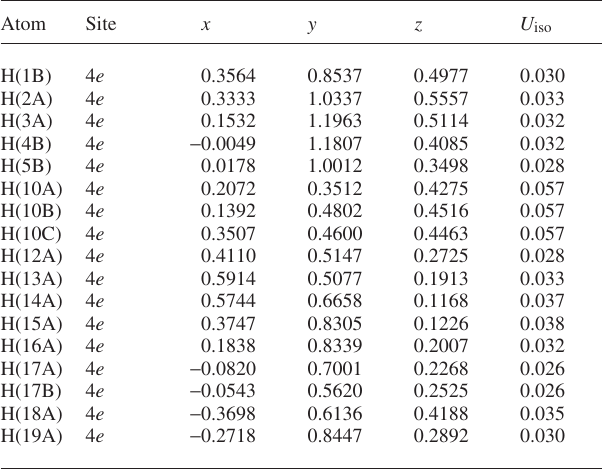
Table 2. Atomic coordinates and displacement parameters (in Å 2 )